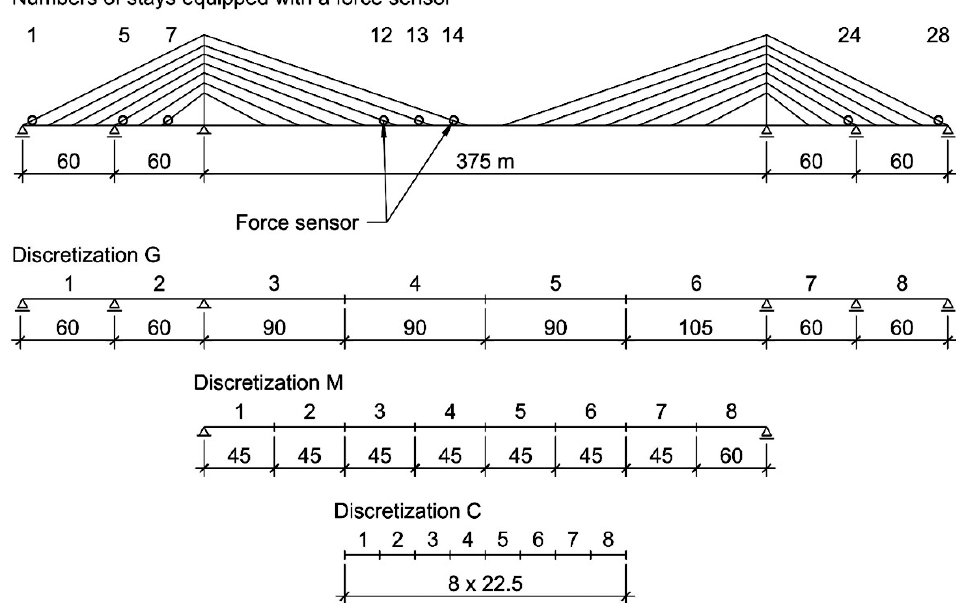
Figure 7. Division of the superstructure into discrete segments to determine a discrete model of load. Three stages of procedure are shown: G, M, C. There are 8 segments in each